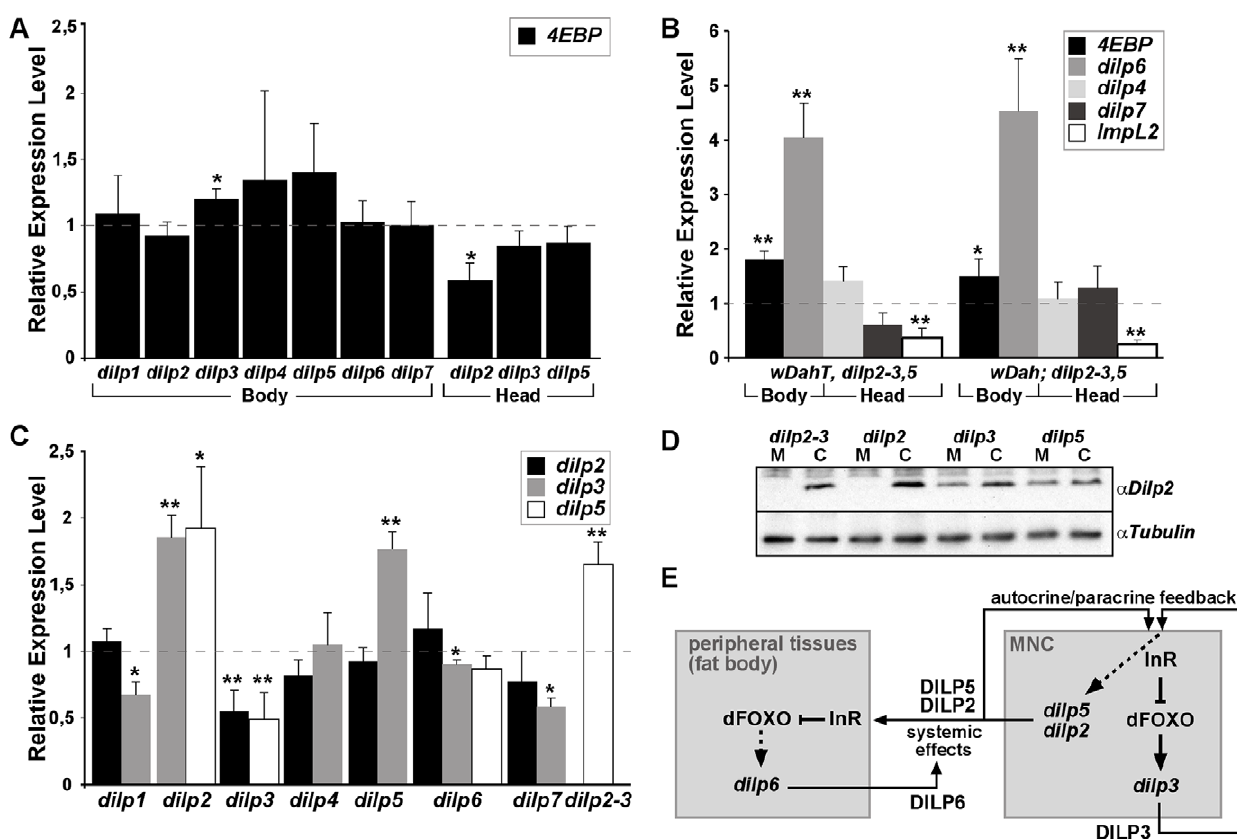
Figure 3. Compensatory regulation of gene expression in dilp mutants. (A) Q-RT-PCR analysis of 4E-BP expression on fly bodies and fly heads of dilp single mutants. Expression of the IIS downstream target gene 4E-BP is not changed in dilp single mutants. (B) Q-RT-PCR analysis demonstrates up-regulation of 4E-BP and dilp6 and down-regulation of ImpL2 in dilp2–3,5 mutants independent of Wolbachia infection status (w DahT : Wolbachia -, w Dah : Wolbachia + ). (C) Compensatory regulation among MNC-expressed DILPs. Expression levels of DILP2, 3, and 5 were measured by QRT-PCR on RNA extracted from heads of dilp mutants. (D) Western blot analysis of DILP2 expression in total head protein confirms lack of DILP2 expression in dilp2 and dilp2 – 3 mutants and downregulation of DILP2 levels in dilp3 mutants. M: homozygous mutant, C: w 111 8 control. An anti-Tubulin antibody was used as loading control. (E) Diagram summarizing the feedback system involved in the control of DILP expression levels. DILP3 is part of a feedback system that acts in an autocrine/paracrine manner to regulate DILP expression in the MNC. DILP expression between MNC in the central nervous system and the peripheral fat body tissue is regulated by a negative feedback system that involves DILP6. See text for further details. Arrows denote activation, blunted lines denote repression. All experiments in (A–D) were done using 8–10 day old females reared on 1x SY-A food. Expression level of mutants were normalised to the corresponding wild type control, which by default was set to 1. * p , 0.05, ** p , 0.01.